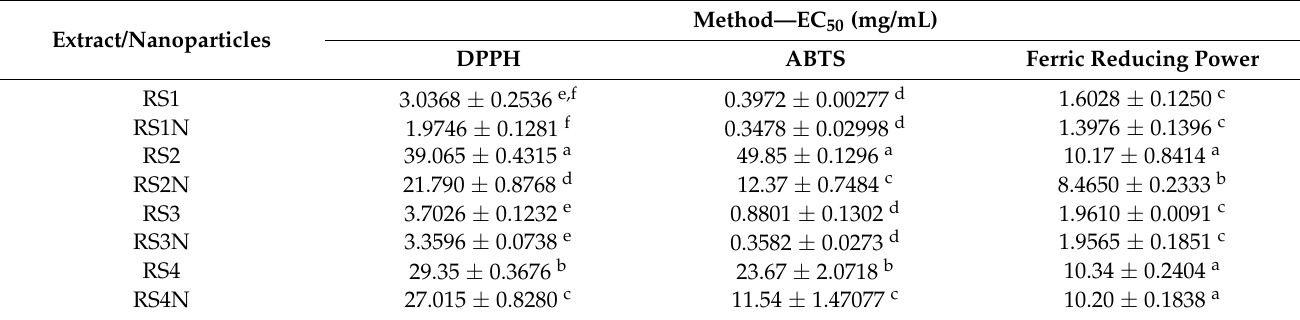
Table 3. Evaluation of antioxidant activity for analyzed extracts and silver nanoparticles *.